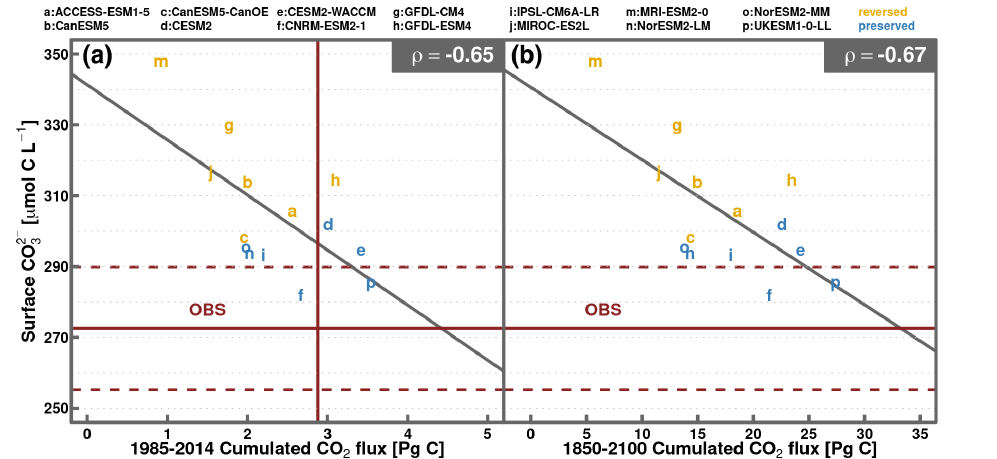
− concentration (in µmolCL − 1 ) plotted against the cumulated sea–air CO 2 fluxes (in PgC) Figure 11. Average contemporary surface CO 2 3 in the EP region from 1985 to 2014 (a) and 1850 to 2100 (b) . ρ is the correlation, and reversed ESMs are marked in yellow, while preserved ESMs are marked in blue. The observations are given as brown lines, with dashed lines being the carbonate observation